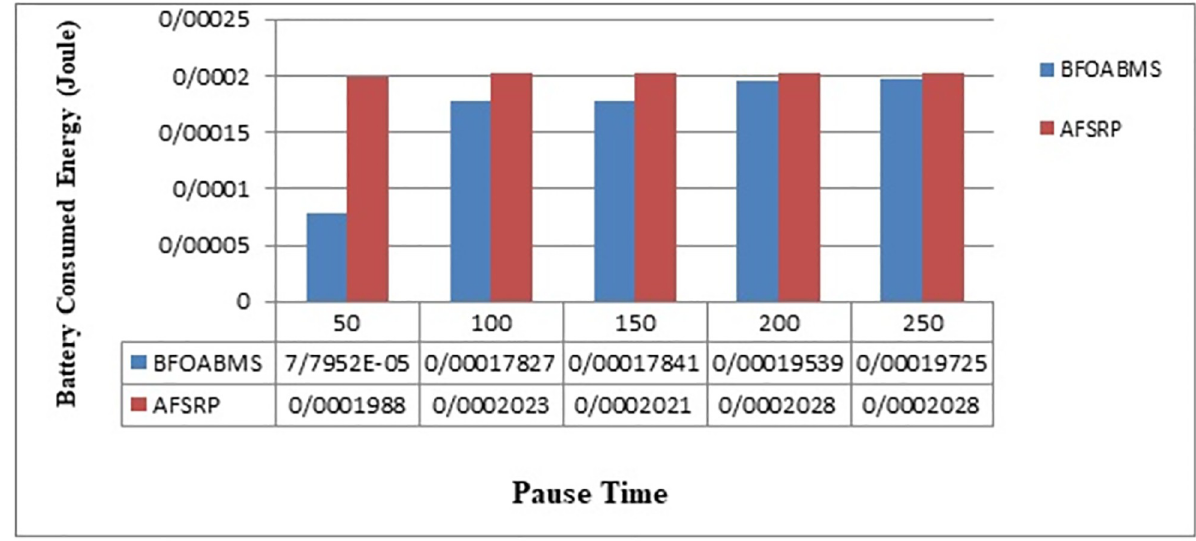
Fig 6. Average energy